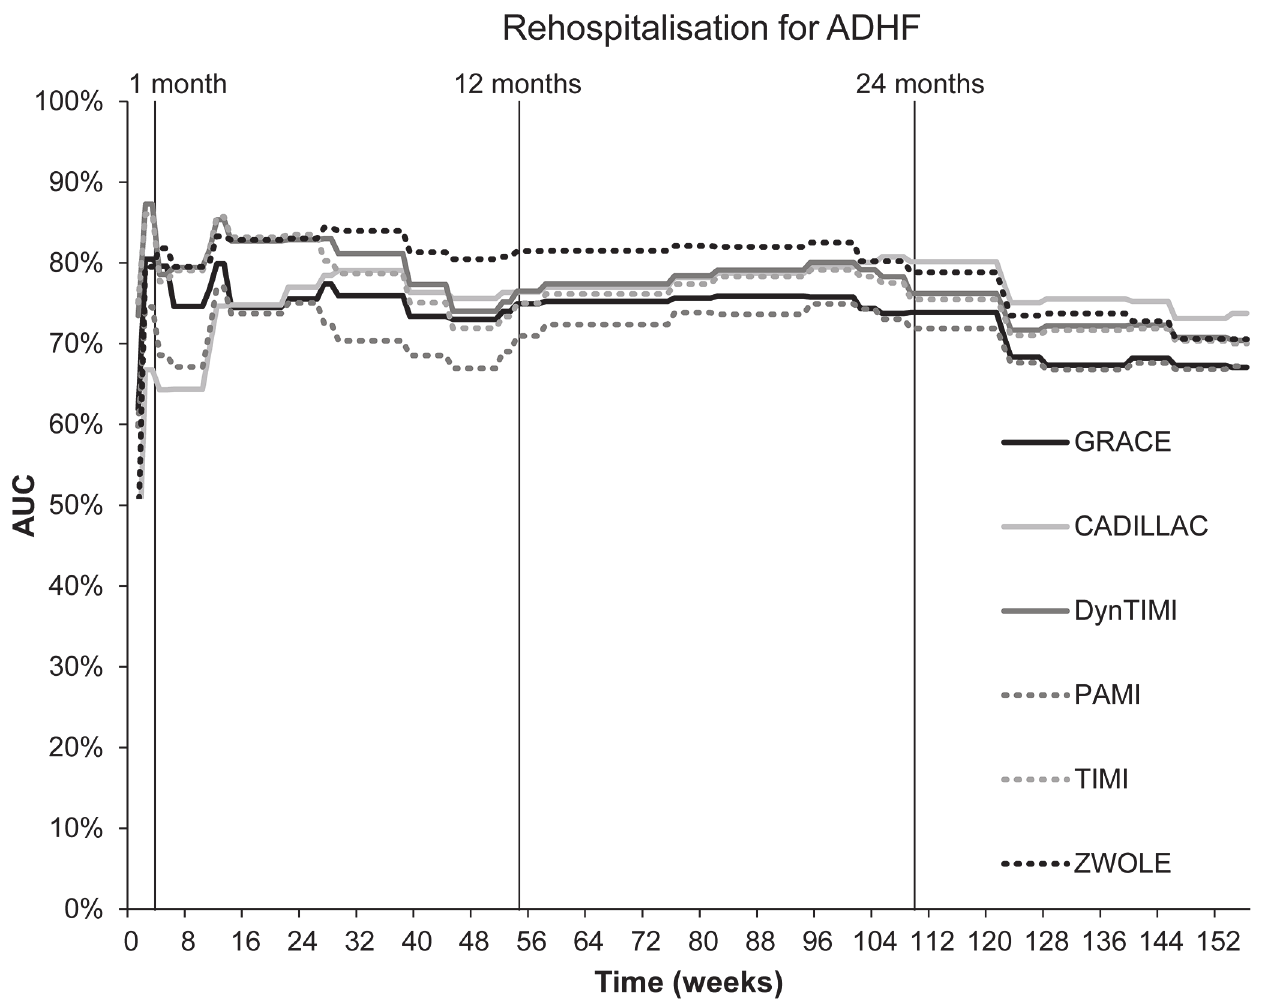
Fig 3. Predictive accuracy of scoring models for rehospitalisation due to ADHF during a three-year follow-up